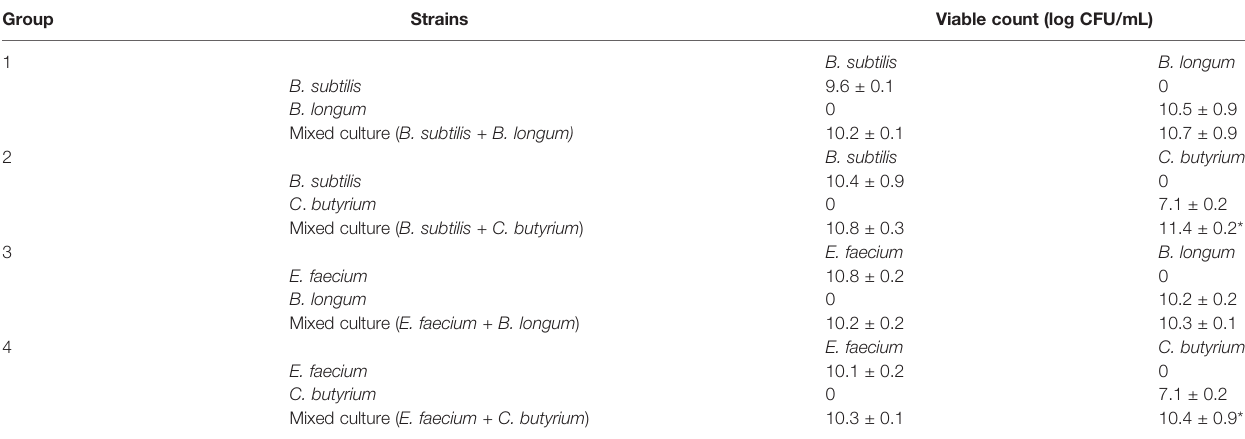
TABLE 1 | Viability bacterial counting for individual and mixed cultures of Enterococcus faecium or Bacillus subtilis cocultured with Bi fi dobacterium longum or Clostridium butyricum . Group